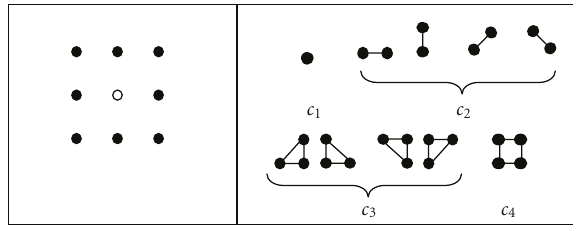
Figure 2: Cliques induced by the eight-point nearest-neighbour